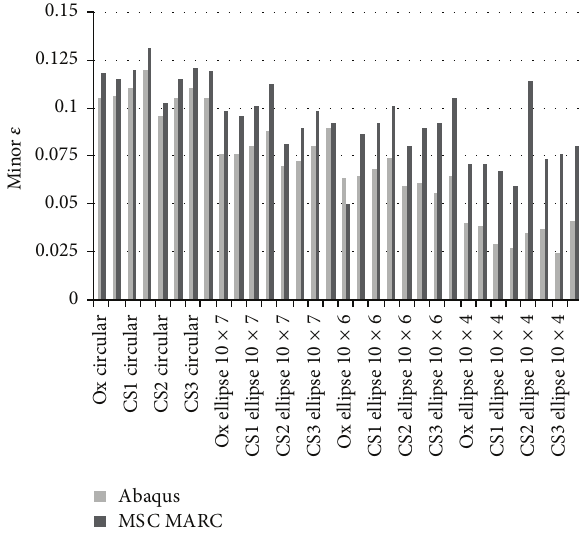
Figure 25: Minimum strain for the bulge tests using Abaqus and